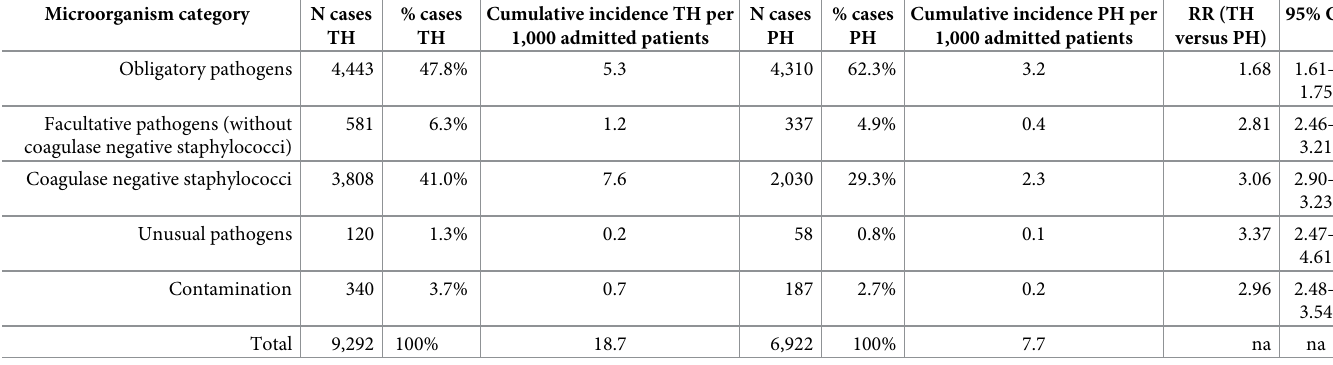
Table 1. Microorganisms, cumulative incidence/1,000 admitted patients and risk ratio (95% confidence interval) by hospital setting. Microorganism